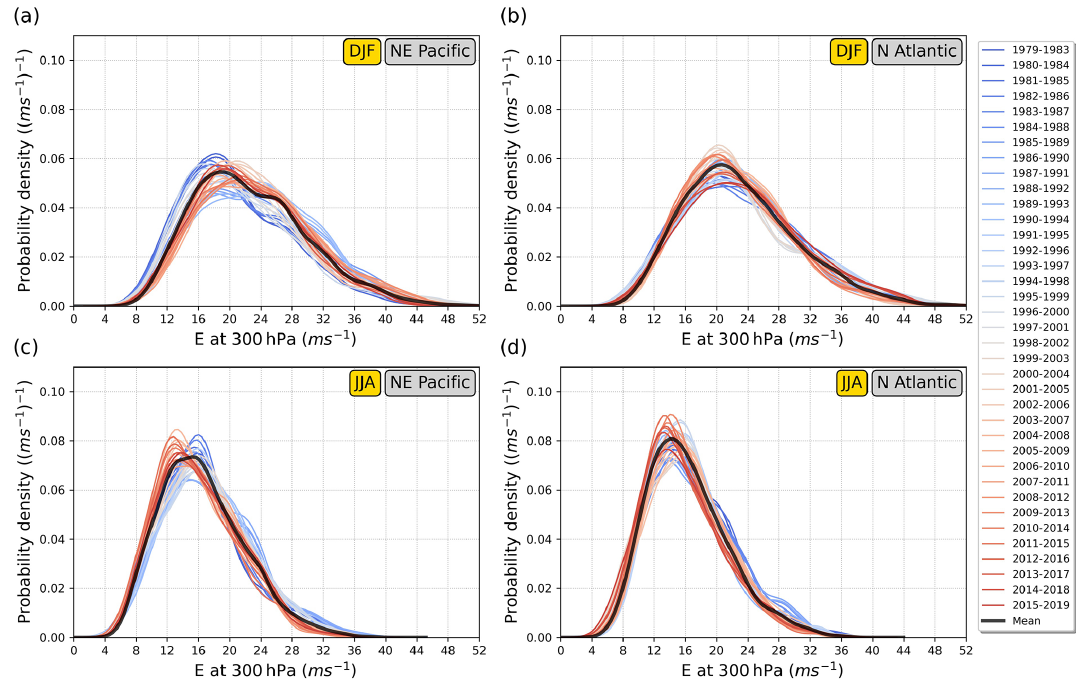
Figure 4. (a) Climatological (1979–2019) PDF of the DJF daily-mean E at 300hPa over NE Pacific based on ERA5 (black line). The coloured lines depict the corresponding PDFs of successive 5-year periods, as indicated in the legend to the right. (b) Same as panel (a) , but for the N Atlantic region. (c, d) Same as panels (a) and (b) , but for the JJA season.